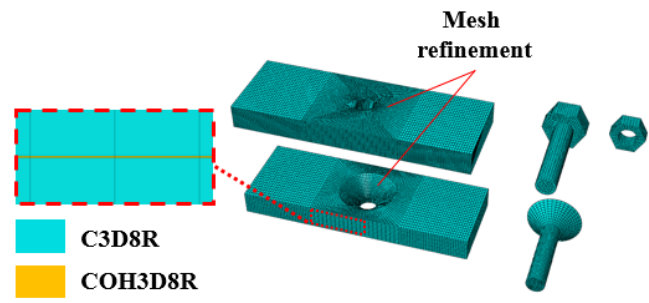
Figure 10. Number of plate layers.